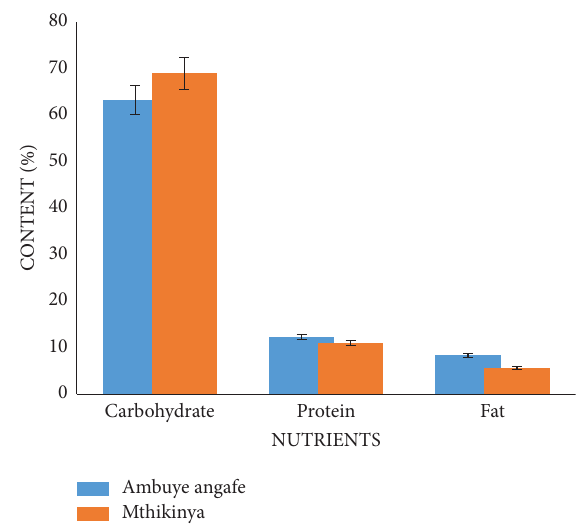
Figure 1: Nutrient content of orange PLMVs from Ntcheu by their local